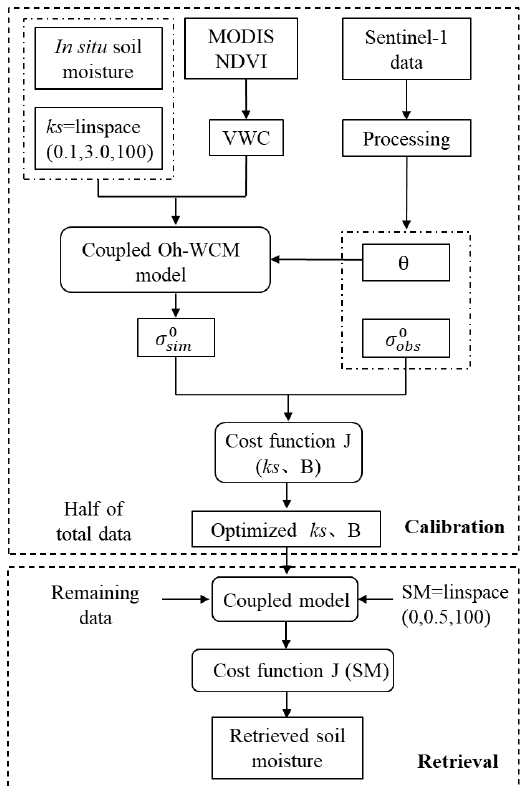
Figure 4. Diagram of model calibration and retrieval of soil moisture.